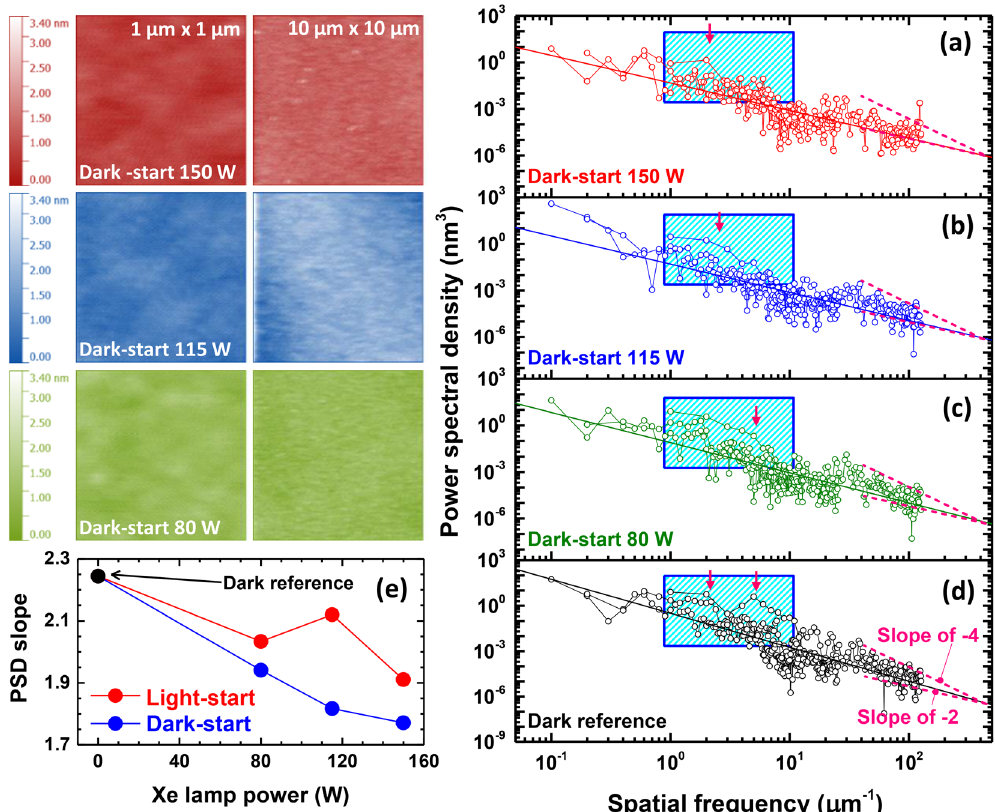
Figure 4. The left-hand portion of the figure displays 1 × 1 μ m 2 and 10 × 10 μ m 2 surface AFM images of the dark-start samples. ( a – d ) Displays their corresponding PSD curves. The curve slopes approached 2 with increasing Xe lamp power. Regions of elevated PSD shifted to lower spatial frequency with increasing lamp power, which indicates that the period of the hillocks on the sample surface increased. ( e ) The PSD slopes of the samples as a function of Xe lamp power. The PSD curve slopes of the light-start and dark-start samples decreased with increasing Xe lamp